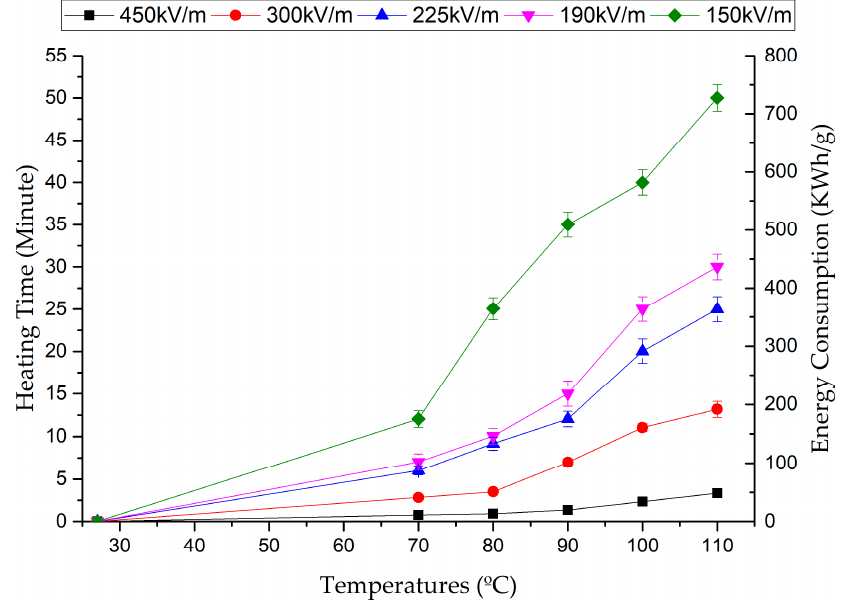
Figure 6. The relative electric field intensity and temperature in the heating system.